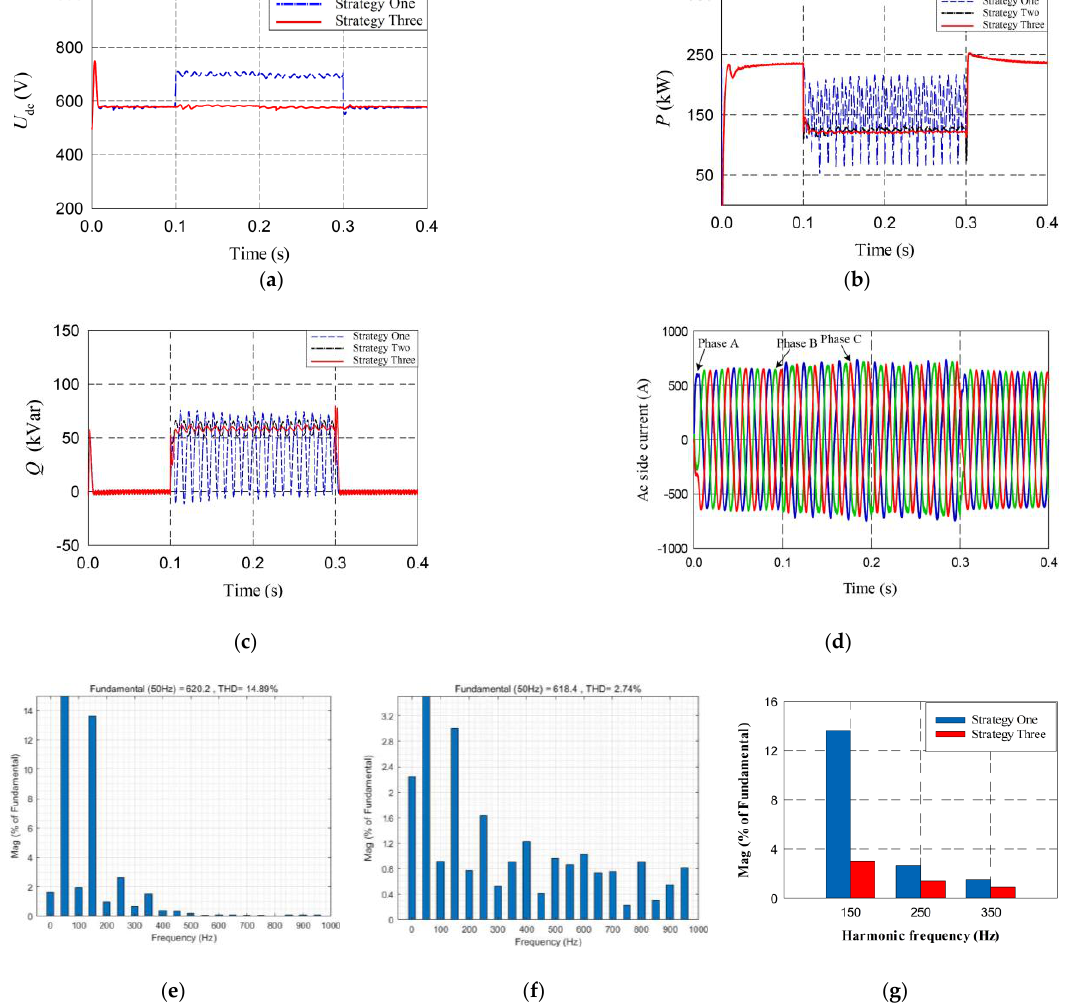
Figure 17. Operating characteristics and waveforms in case of phase A voltage sag under different control strategies: ( a ) DC bus voltage; ( b ) Active output power of the inverter; ( c ) Comparison of output reactive power of inverter; ( d ) Grid current under strategy Three; ( e ) The THD ( i.e., total harmonic distortion) of grid current under strategy One; ( f ) The THD of grid current under strategy Three; ( g ) Harmonic currents under strategy One and strategy Three.